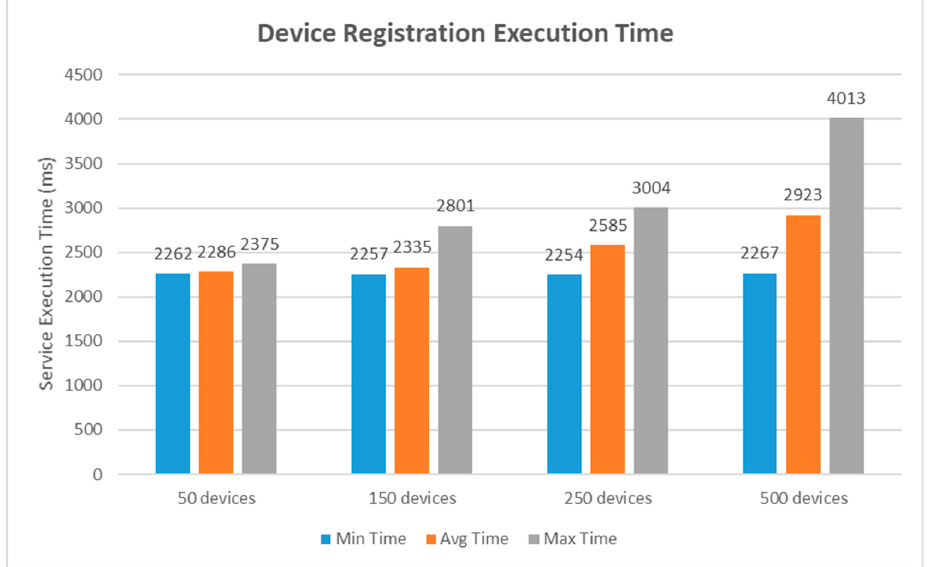
Figure 15. Performance analysis graph of device creation. Sensors 2019 , 19 , 2228